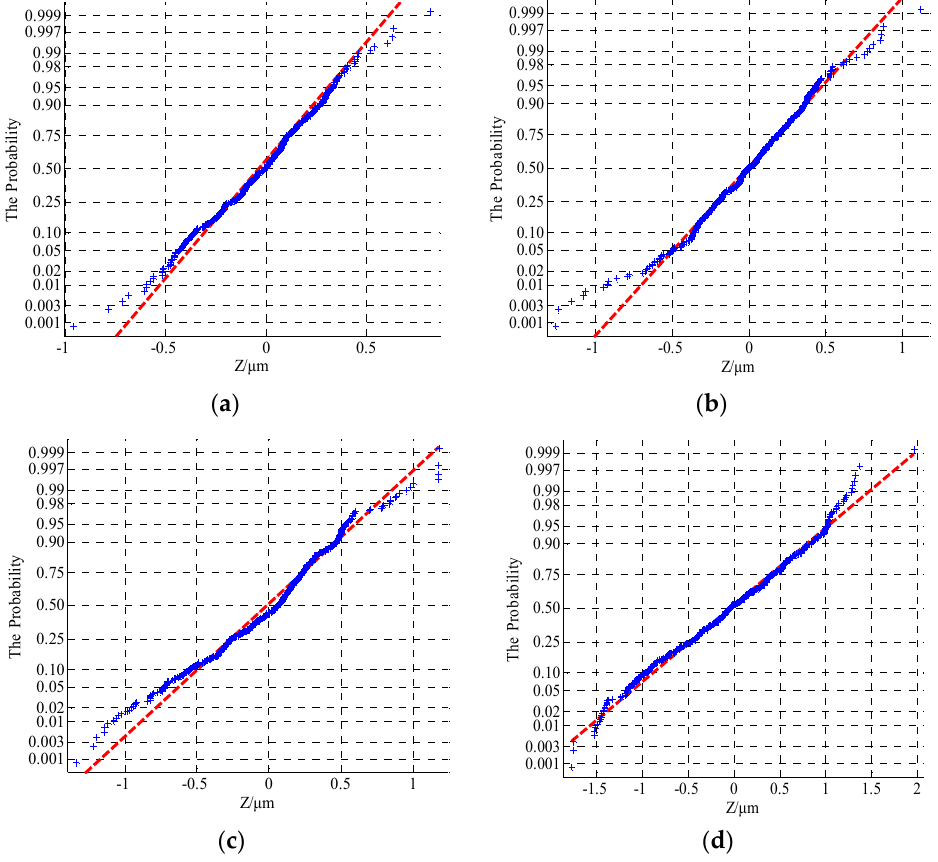
Figure 8. QQ test figure for different surface morphology ( a ) The upper surface of the specimen 1; ( b ) The lower surface of the specimen 2; ( c ) The upper surface of the specimen 3 and ( d ) The lower surface of the specimen 4.